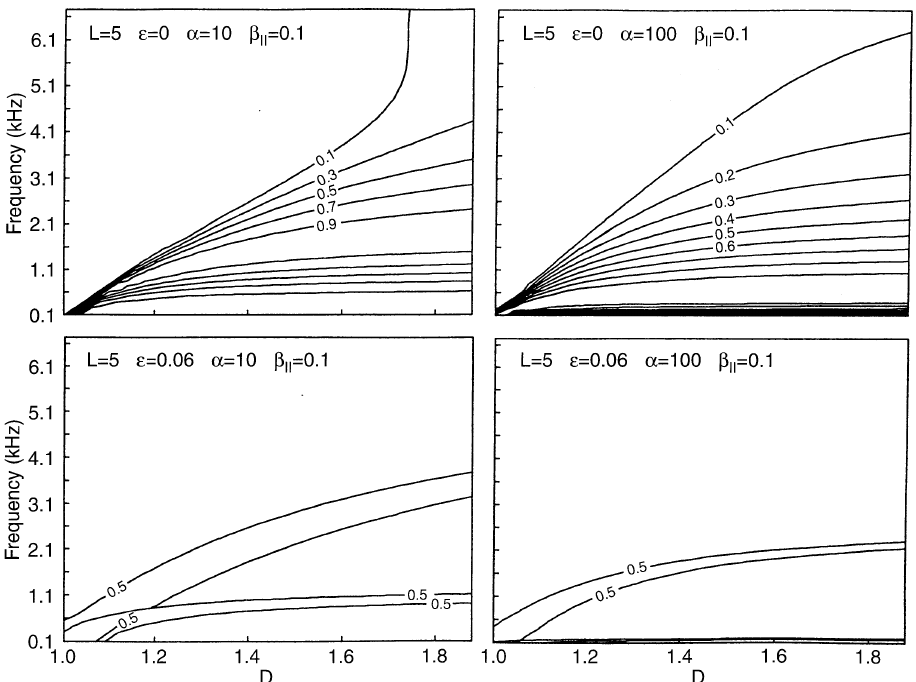
Fig. 7. „ op panel : undisturbed VLF-wave generation band as a function of electron anisotropy factor D "„ (cid:77) / „ (cid:69) for two values of the magnetosphere electron plasma parameter (cid:97)(cid:98) (cid:69) . Both (cid:97) " n / n (cid:98) (cid:69) values in the (cid:56)(cid:33)(cid:51)(cid:46) and figure are given for the equatorial plane. ‚ abels on curves denote the logarithm of the VLF-wave out- put intensity in (cid:67) / (cid:67) (cid:46)(cid:33)(cid:57) value units, where (cid:67) is the path-integ- rated growth rate and (cid:67) (cid:46)(cid:33)(cid:57) is its maximum value for given D and (cid:97)(cid:98) (cid:69) . Bottom panel : in the same frame the VLF-wave generation band cut at level 0.5 in presence of the magnetic-field perturbation of 15-nT amplitude. Upper and lower band positions correspond to positive and negative phases, respectively, of the magnetic-field perturbation